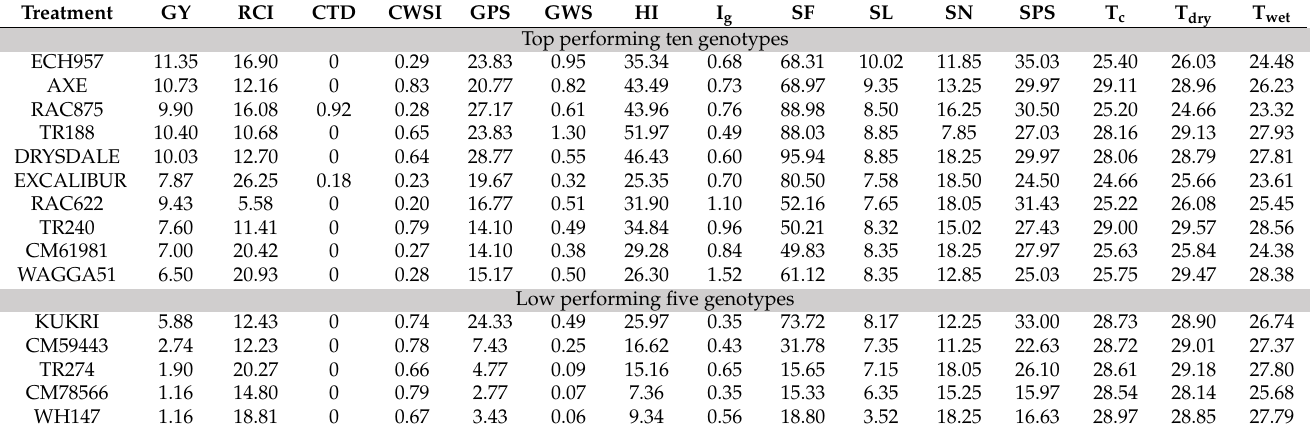
Table 5. Adjusted mean values of the ten best-performing and five low-performing genotypes under heat stress. Genotypes are ranked based on enlisted traits in the table.